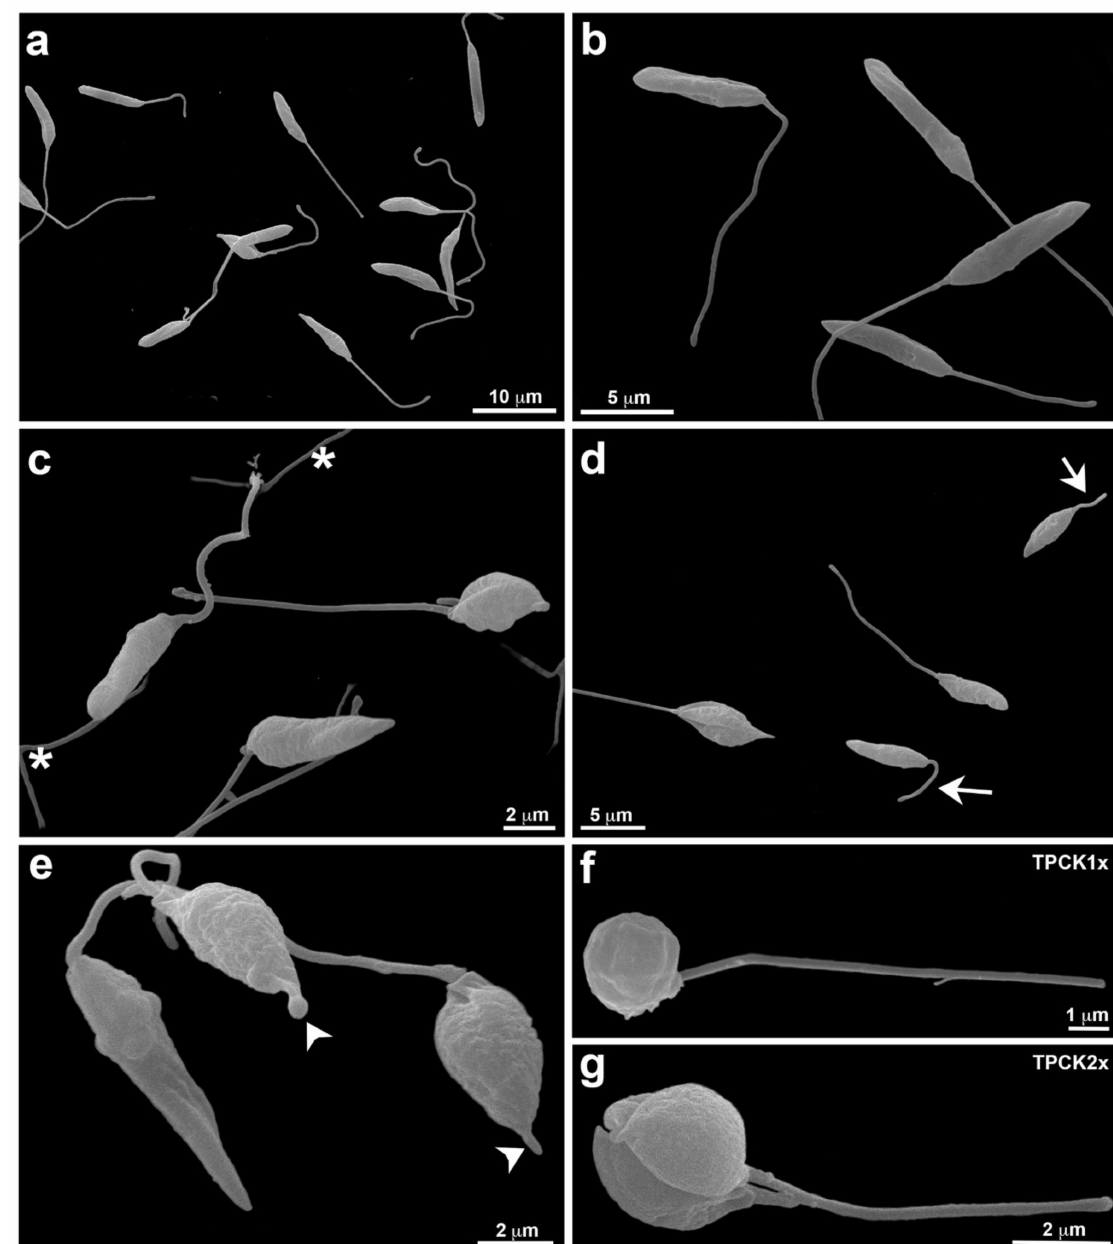
Figure 6. Morphology of L. infantum promastigotes treated with TPCK, as observed using SEM. (( a , b ) Control (no treatment), note the regular cell morphology; ( c ) promastigotes treated with TPCK at 12 µ M displaying parasite cell body alteration and loose flagella portions in the background (asterisks); ( d , e ) promastigotes treated with TPCK at 24 µ M, parasite cell body changes can also be observed and short flagella are visualized ( d —arrow). A membrane projection in the anterior body portion is noted ( e —arrowhead); ( f ) promastigotes treated with TPCK at 12 µ M; ( g ) promastigotes treated with TPCK at 24 µ